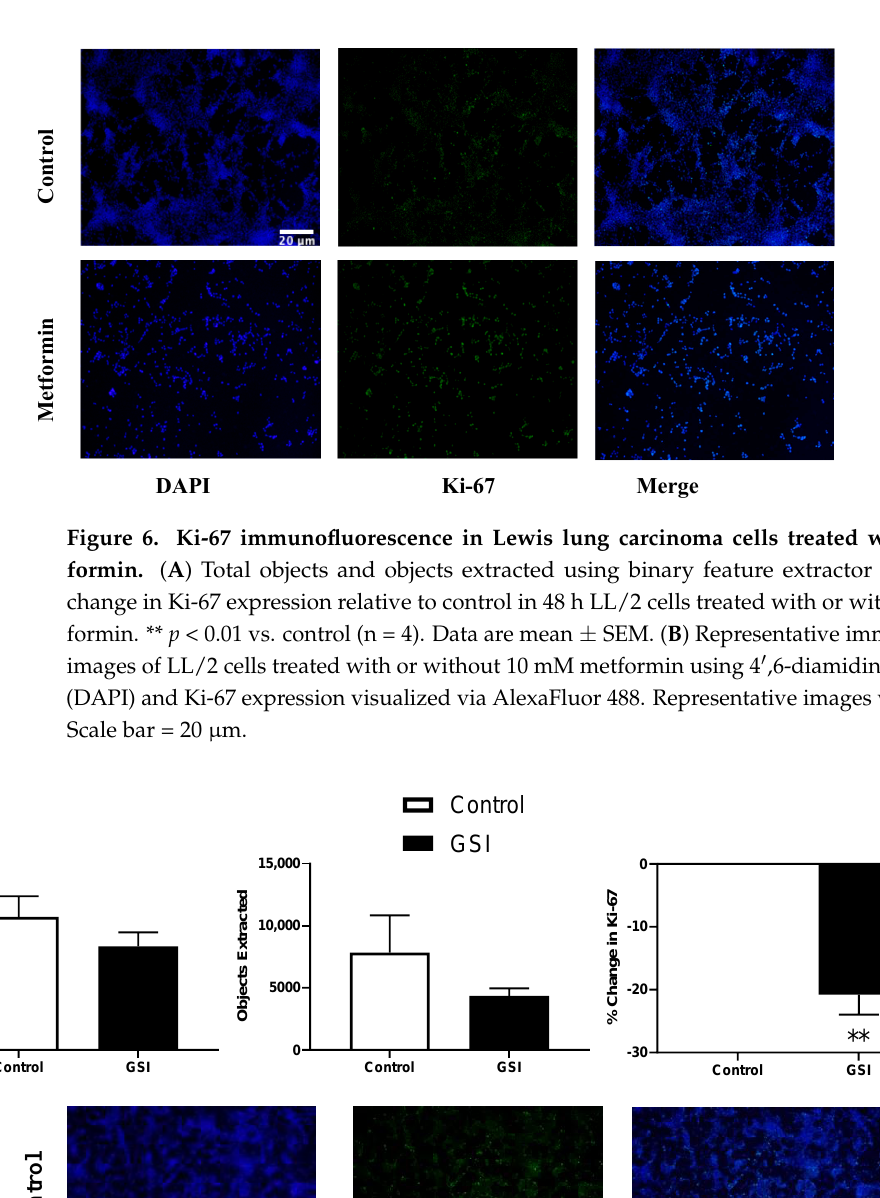
Figure 7. Ki-67 immunofluorescence in Lewis lung carcinoma cells treated with GSI. ( A ) Total objects and objects extracted using binary feature extractor via Fiji. Percent change in Ki-67 expres- sion relative to control in 48 h LL/2 cells treated with or without 4 µM Ɣ -secretase inhibitor (GSI) every 12 h. ** p < 0.01 vs. control (n = 5). ( B ) Representative immunofluorescence images of LL/2 cells treated with or without 10 mM metformin using 4’,6-diamidino-2-phenylindole (DAPI) and Ki-67 expression visualized via AlexaFluor 488. Representative images were taken at 10x. Scale bar = 20 µm.